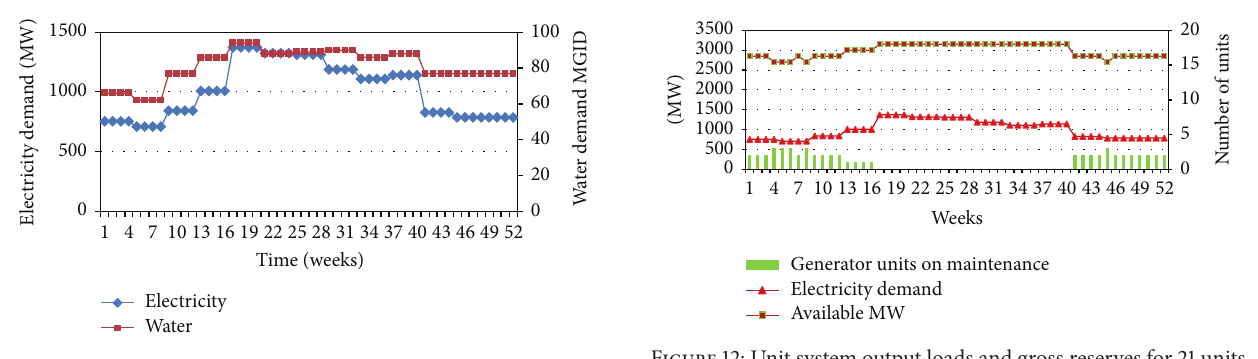
Figure 11: Input demand for the model.